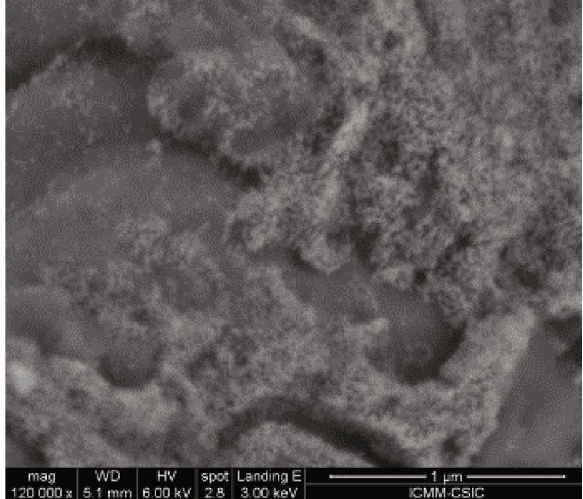
Figure 2: SEM image of 2Cloi/TiCe10 catalyst. The width of the micrograph is 2.43